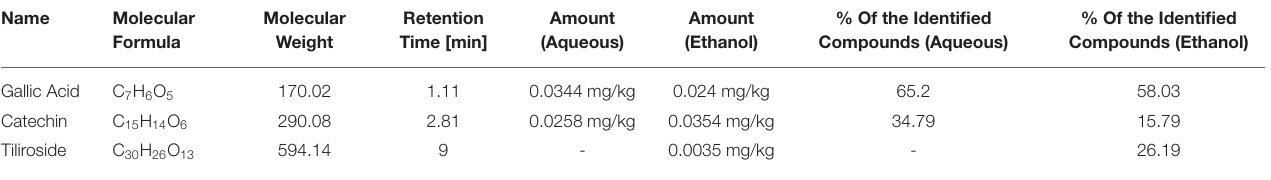
TABLE 2 | The components of Gaz alafi extracts using LC-MS qualitative